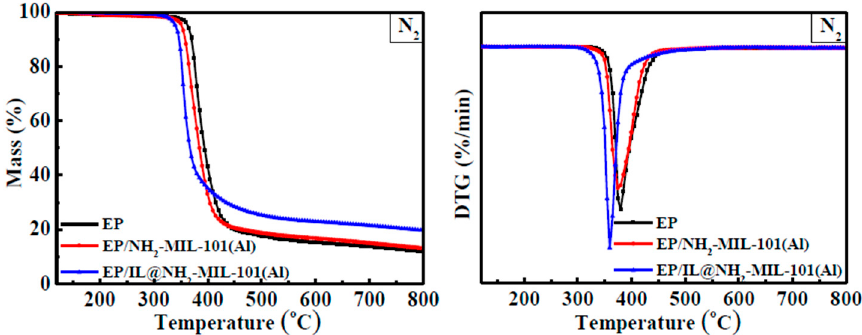
Figure 8. TG and DTG curves of EP and EP composites under N 2 conditions. Table 2. TGA parameters of EP and EP composites.